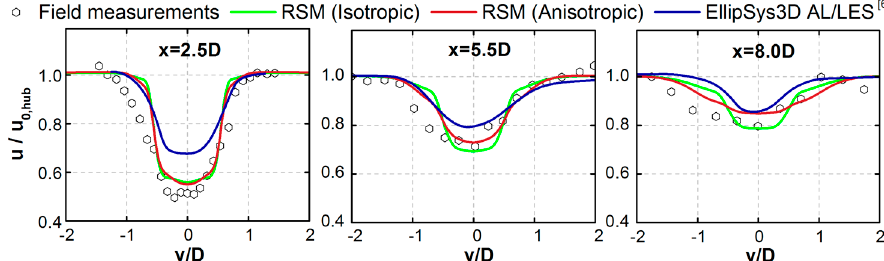
Figure 3. Horizontal distributions of normalized wake velocity at hub height at downstream distances of 2.5 D , 5.5 D , and 8.0 D . Comparison between predictions obtained from the AD / RANS_RSM under isotropic and anisotropic turbulence inflow conditions, and field measurements (experimental data obtained from Cleijne [33]). Besides, in order to avoid the uncertainty in measurements and assess the performance of the AD / RANS method fairly, numerical results [6] obtained from the AL / LES computations using Technical University of Denmark (DTU’s) CFD solver EllipSys3D are also included.